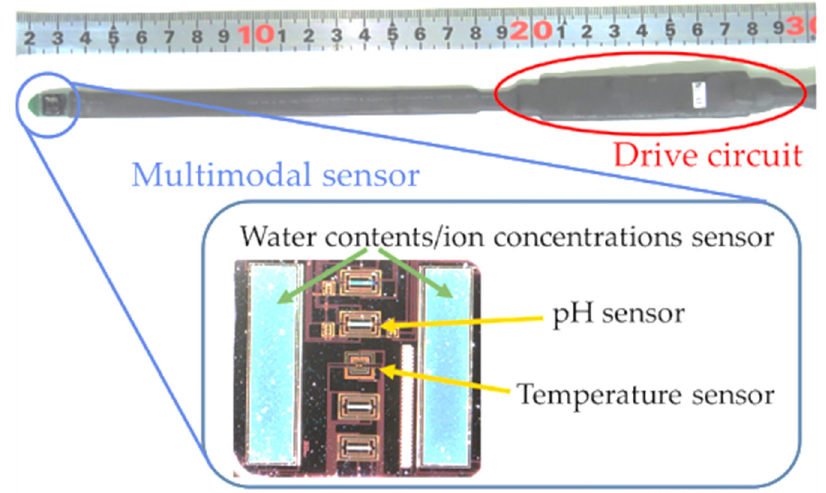
Figure 1. Multimodal sensor.